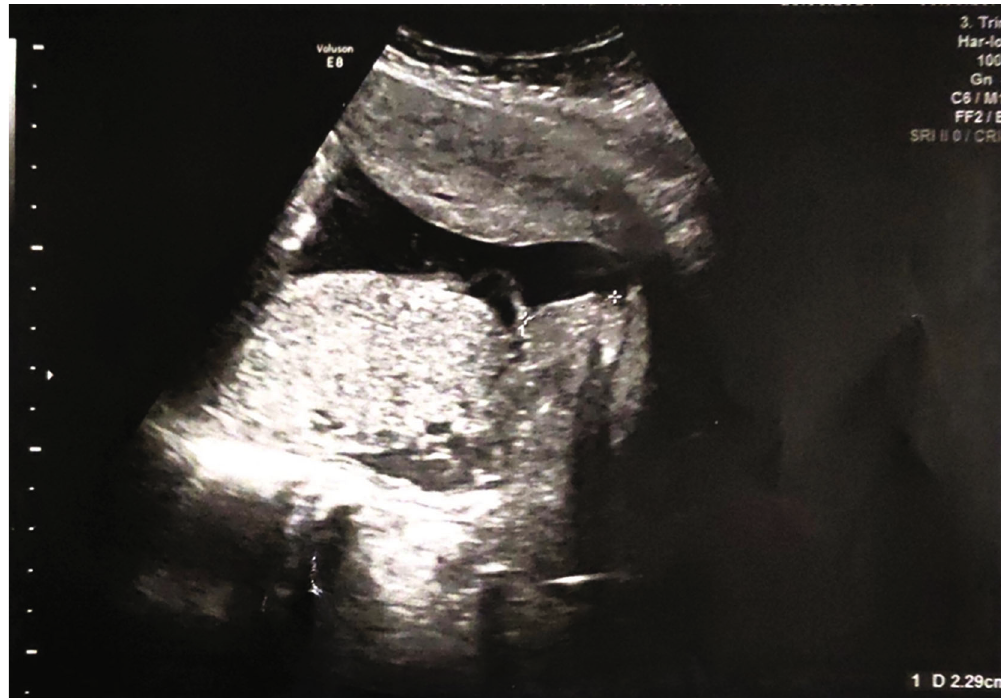
Figure 1: Transvaginal ultrasound indicates the leading edge of placenta at 2.29cm from the internal os on the day the woman presented at the